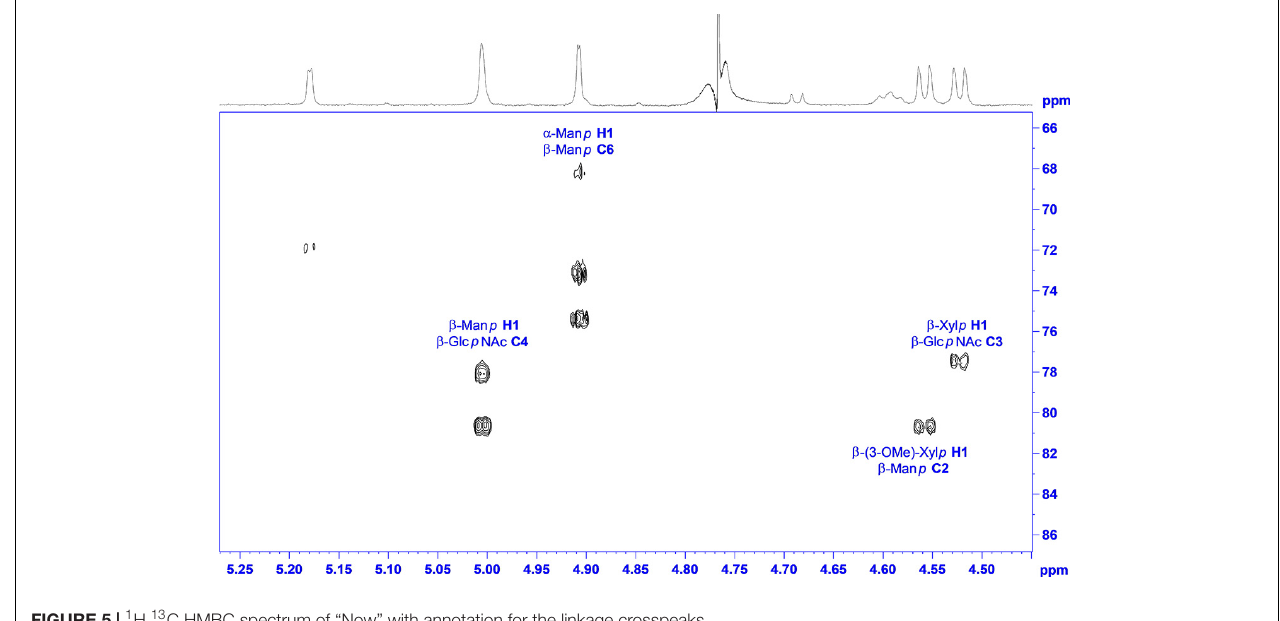
FIGURE 5 | 1 H, 13 C HMBC spectrum of “Now” with annotation for the linkage crosspeaks.